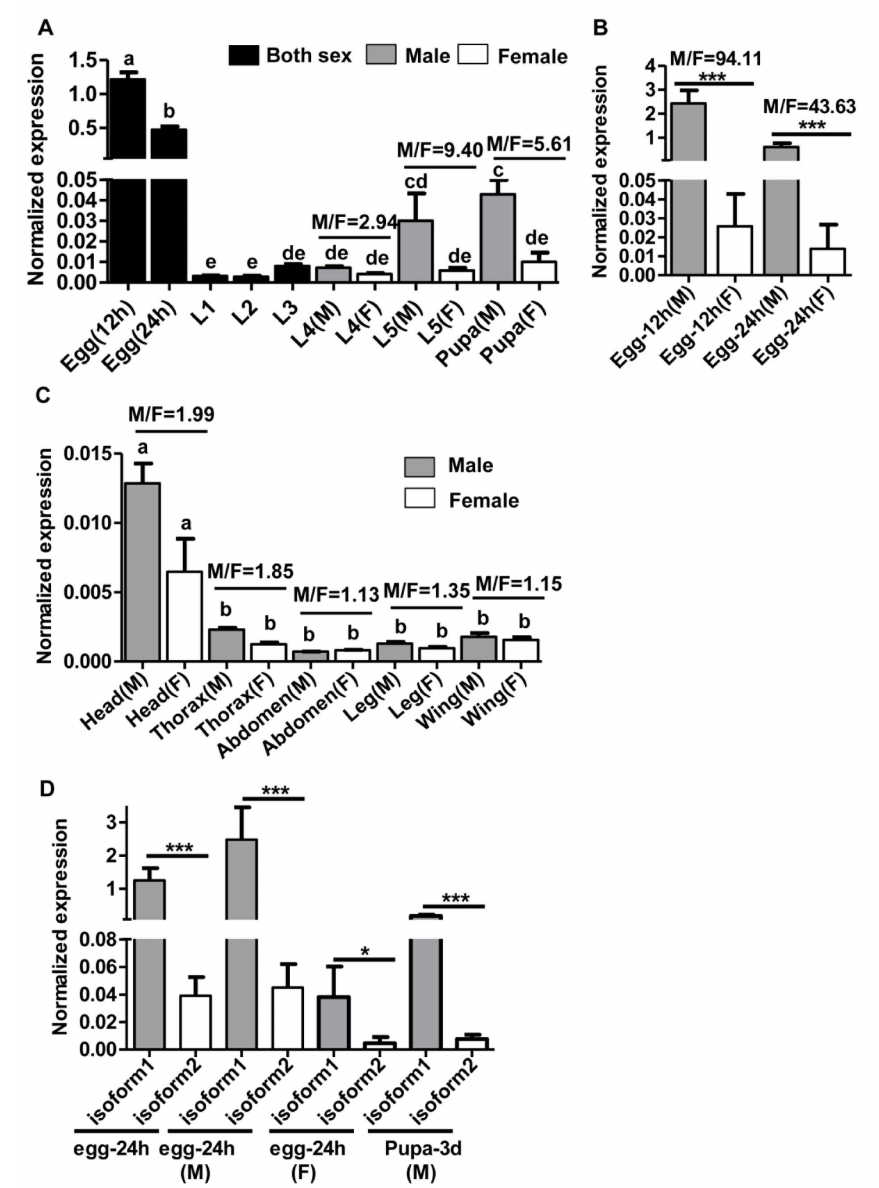
Figure 5. Expression profiles of HaMasc. ( A ) RT-qPCR analyses of HaMasc in unsexed (eggs to the third instar larvae (L3)) and sexed (L4 (the fourth instar larvae) to pupa) development stages. ( B ) RT-qPCR analyses of HaMasc in sexed eggs (12 h and 24 h). ( C ) RT-qPCR analysis of HaMasc in different body parts of newly emerged male (M) and female (F) adults. ( D ) RT-qPCR analysis of the two HaMasc isoforms ( HaMasc1 and HaMasc2 ) in eggs (24 h, unsexed) and male pupa. Bars in ( A – D ) are means ± SE of normalized expression of HaMasc based on at least three biological replicates. Bars with different letters such as a, b, c, d, and e in Figure 5A,C ( p < 0.05, one-way ANOVA followed by Tukey’s HSD test) are significantly different. Bar pairs with one asterisk ( p < 0.05, independent t -test) and three asterisks ( p < 0.001, independent t -test) in Figure 5B,D are significantly and extremely different,